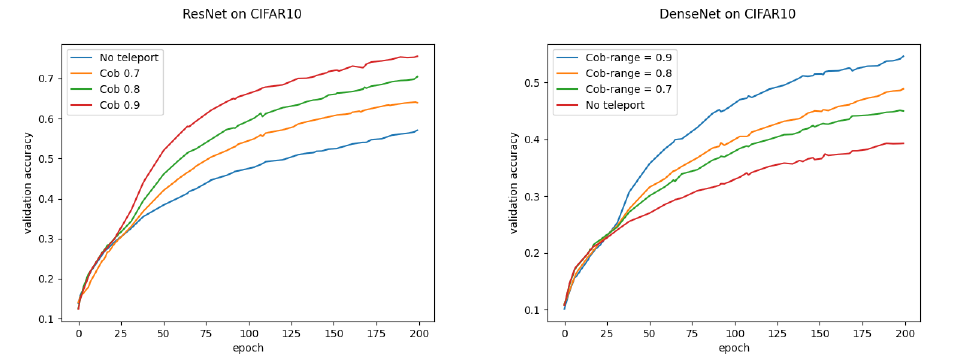
Figure 12. Validation accuracy for ResNet ( left ) and DenseNet ( right ). We plot four curves for each model each one corresponding to applying one teleportation at epoch 30 with different